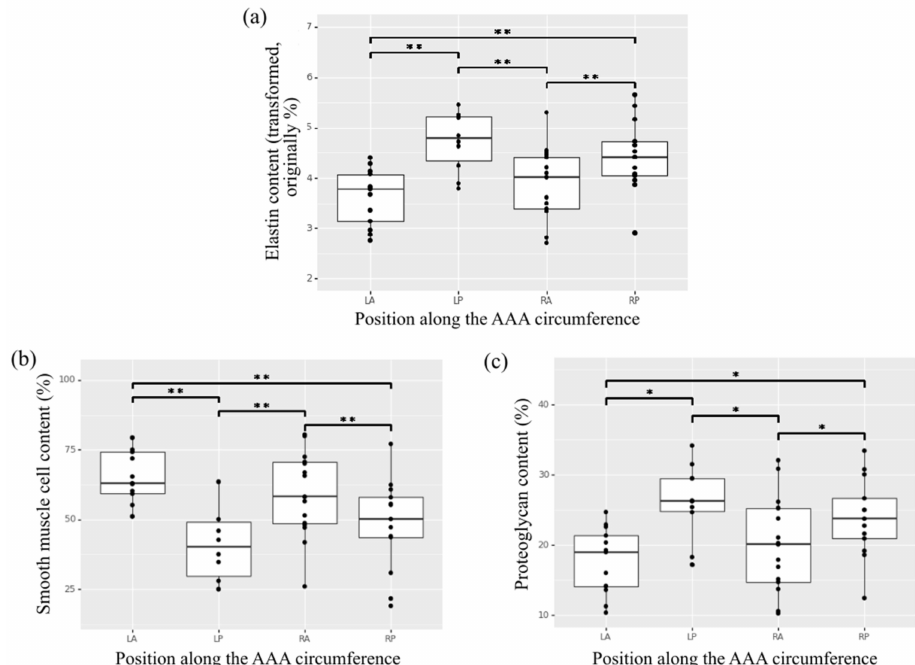
Figure 5. Heterogeneity of content along the circumference of the AAA for the aortic wall constituents ( a ) elastin, ( b ) smooth muscle cells, and ( c ) proteoglycans in the media of histological aortic samples. * indicates p value < 0.05, ** indicates p value <